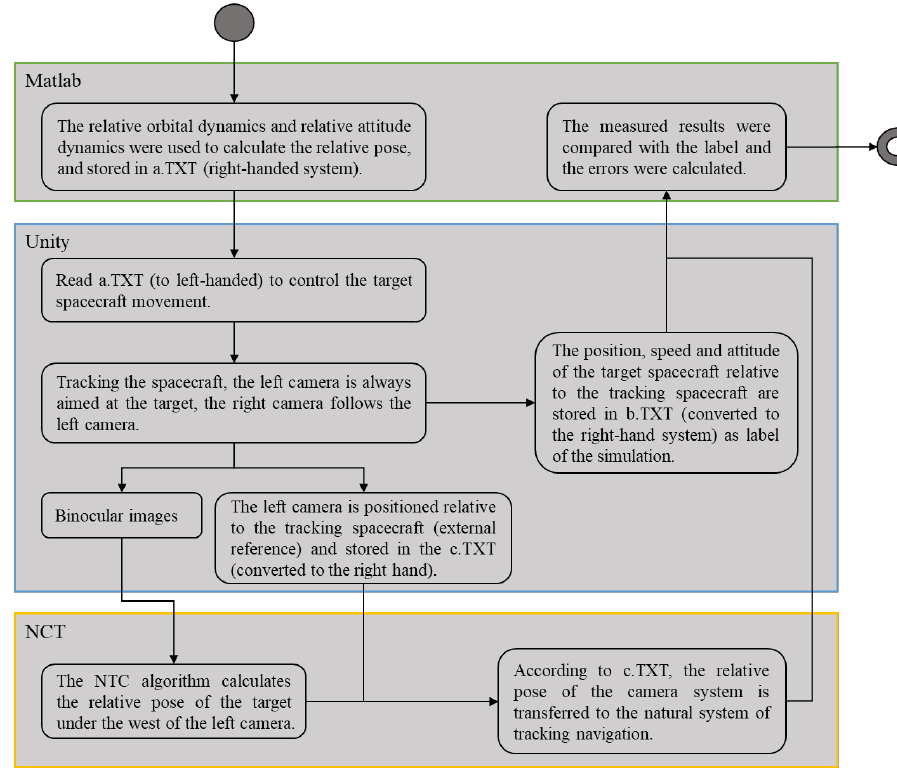
Figure 8. The overall process of the simulation experiment